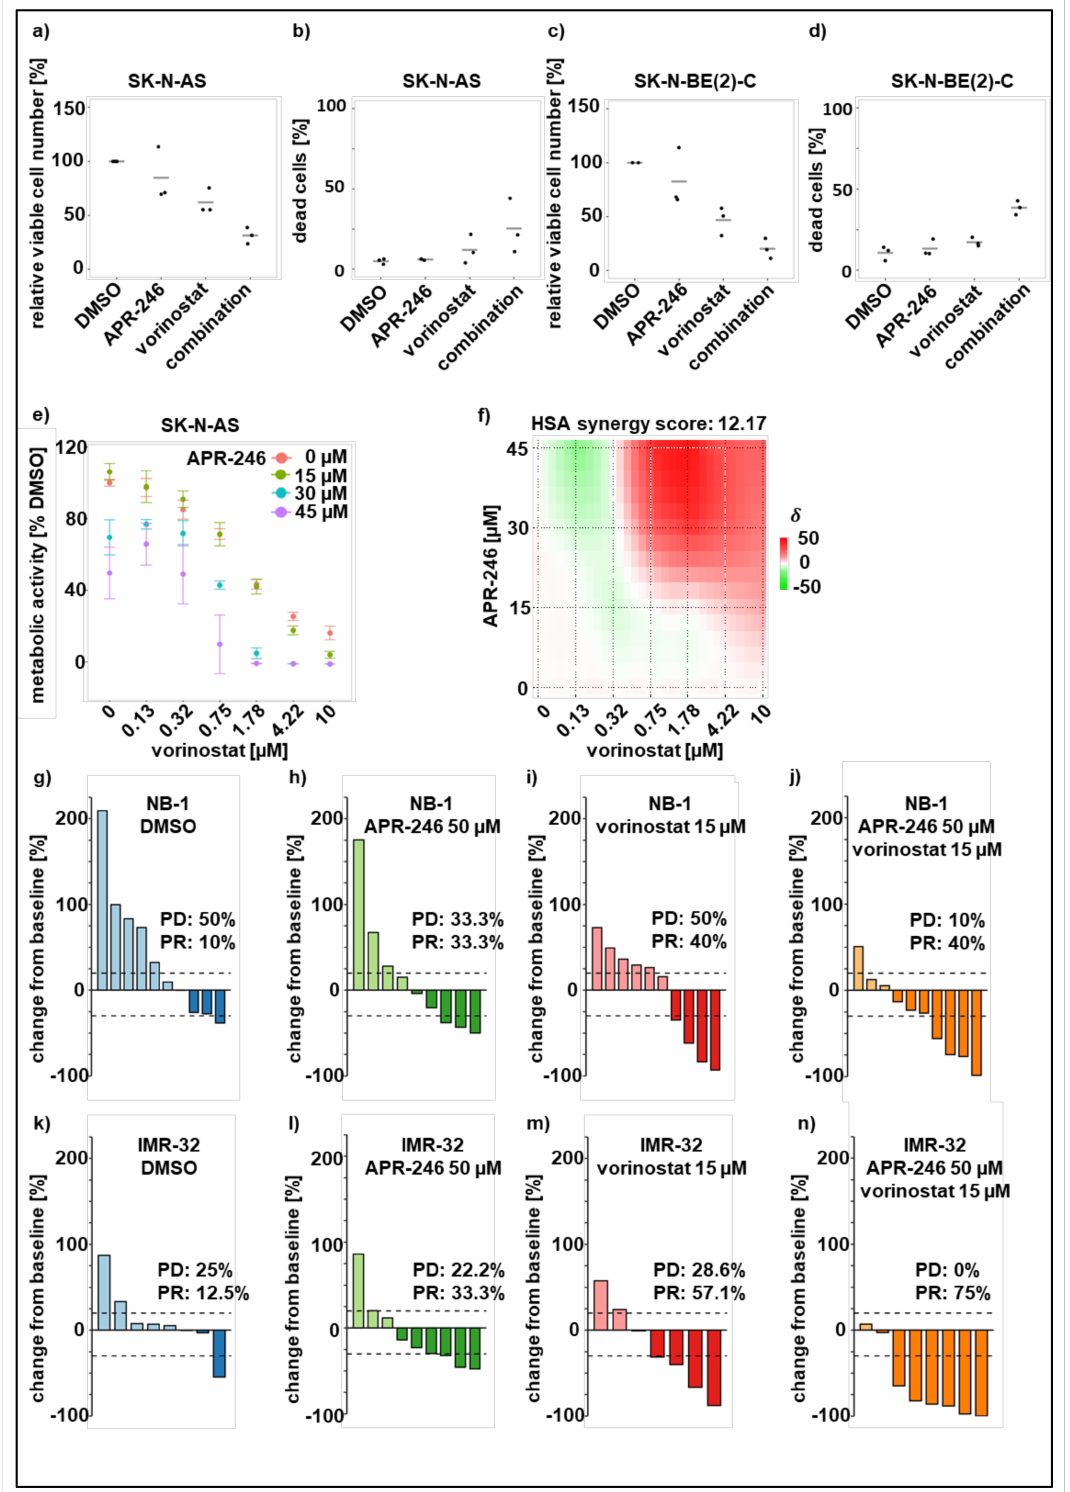
Figure 4. Combining APR-246 with HDAC inhibition effectively sensitizes neuroblastoma in vitro and in vivo. Determina- tion of viable cell number/mL normalized to solvent (DMSO)-treated cells ( a , c ) and dead cell count ( b , d ) after automated Trypan blue exclusion assay of neuroblastoma cell lines SK-N-AS and SK-N-BE(2)-C. Cells were pretreated with 0.5 µ M vorinostat for 72 h and afterwards treated with 20 µ M APR-246 for 24 h. Bars indicate control, single and sequential treatment; ( e , f ): metabolic activity measurement via CellTiter Glo-assay in neuroblastoma cell line SK-N-AS after 72 h